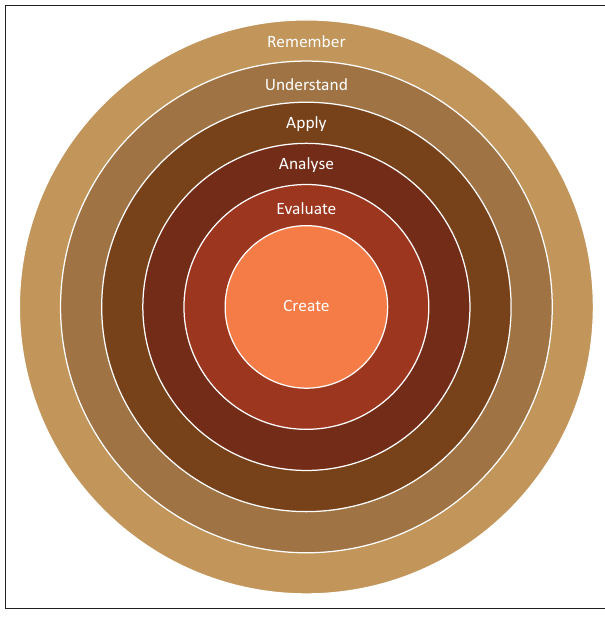
FIGURE 2: Diagram of the spiderweb frame, using Bloom’s revised